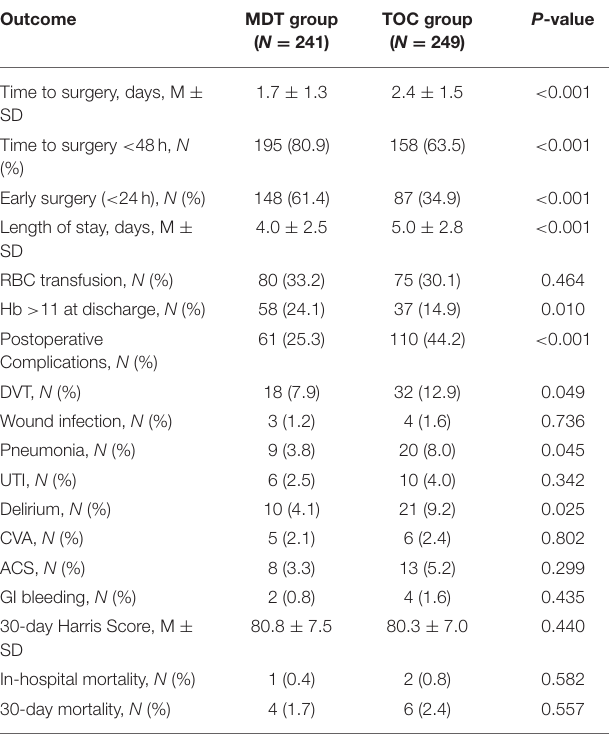
TABLE 2 | Clinical indicators grouped by orthogeriatric co-management and orthopedic usual care.